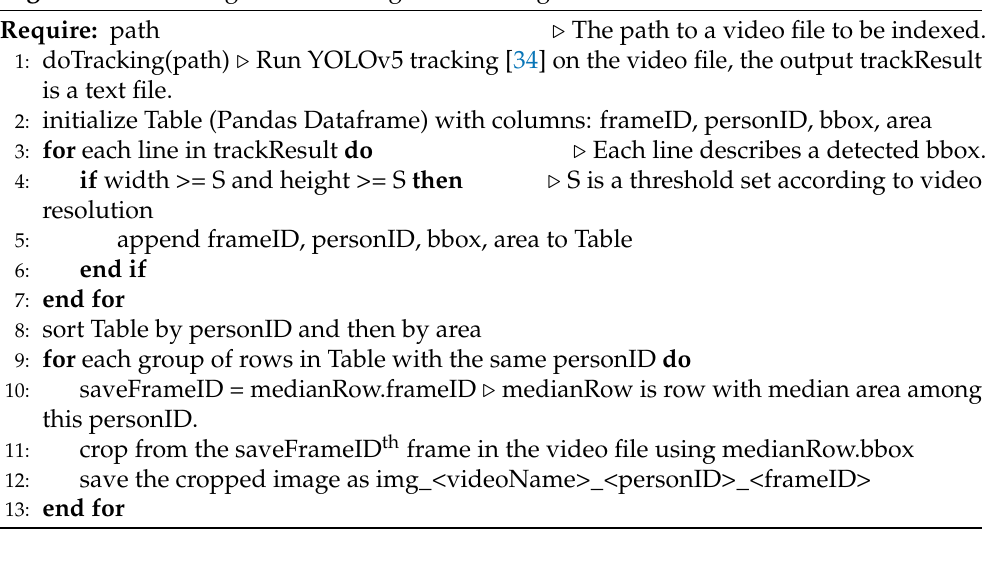
Algorithm 1 Tracking and Bounding Box Filtering